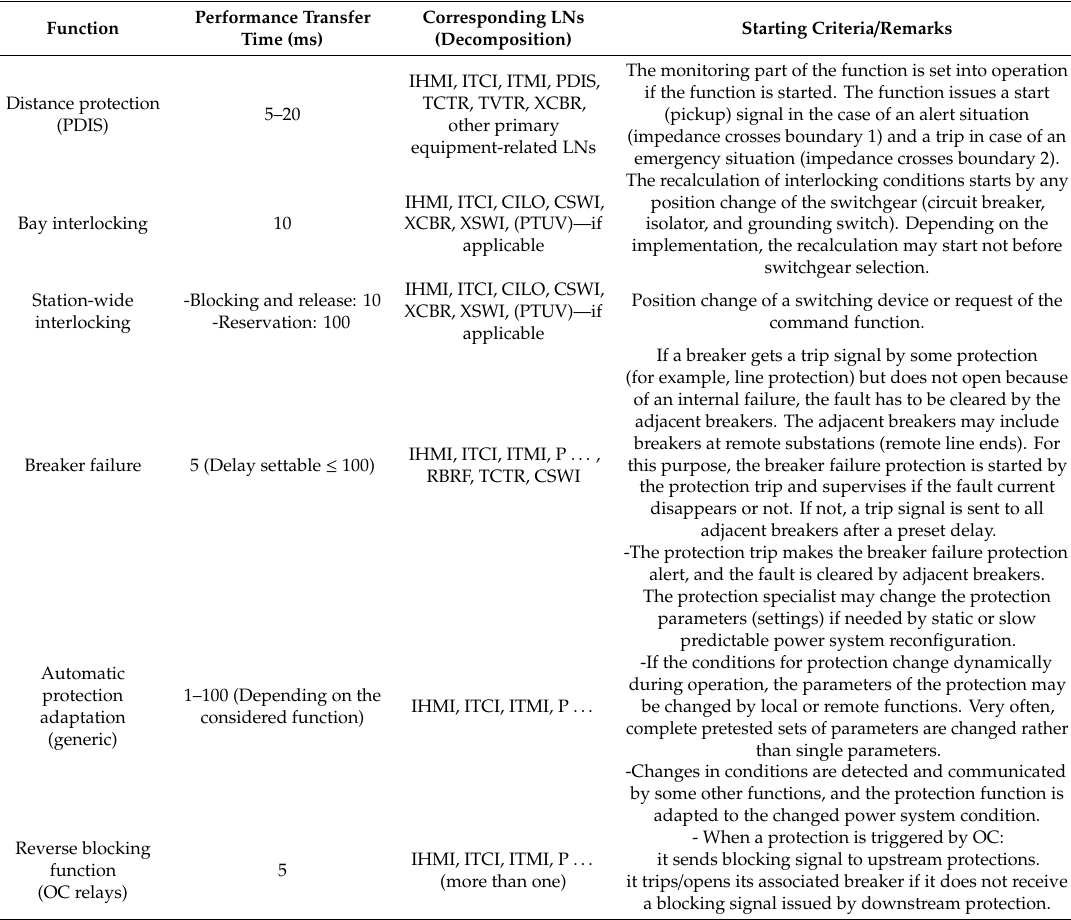
Table 1. Protection functions, logical nodes and performance requirements as per IEC 61850-5:2003 (Annex G)